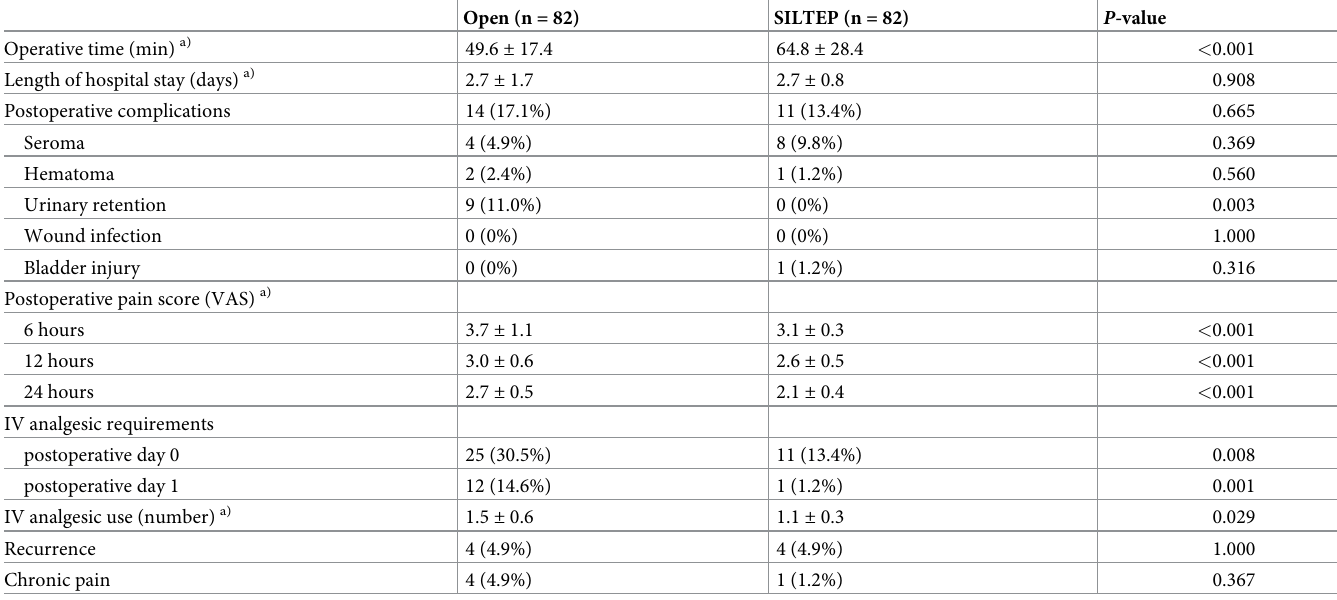
Table 3. Surgical outcomes of